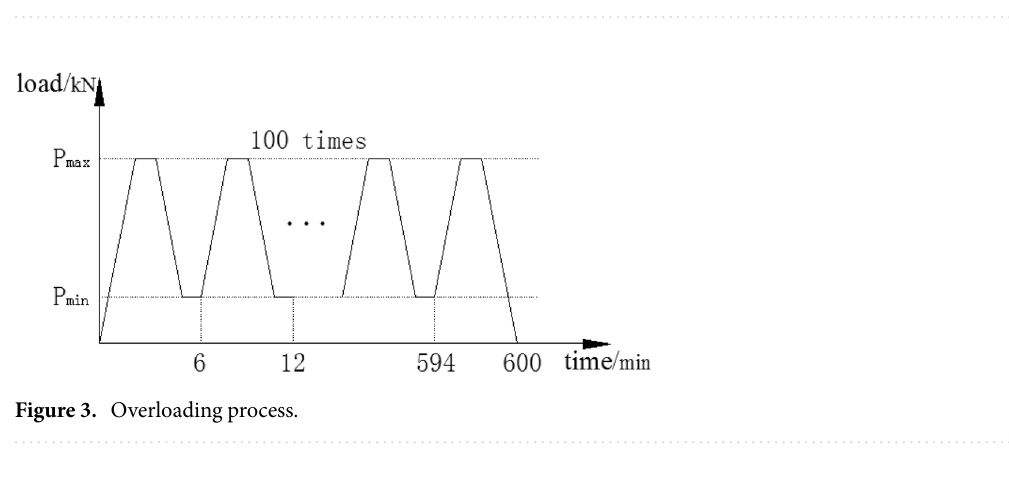
Figure 2. Schematic of locations of the displacement meters and strain gauges at beam.